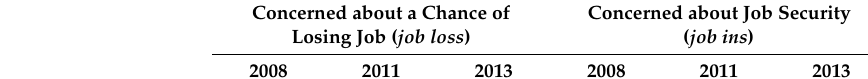
Table 2. Cont. Concerned about a Chance of Losing Job ( job loss )